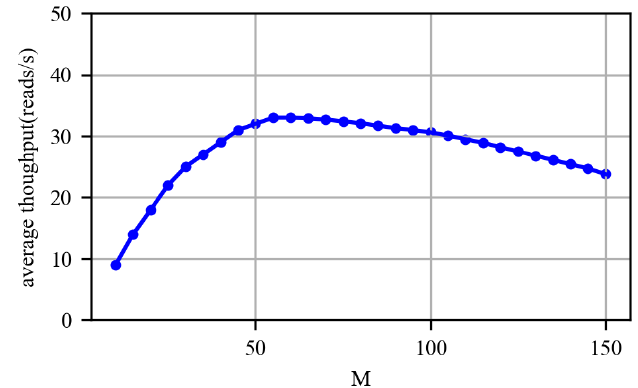
Figure 9. The impact of period length on